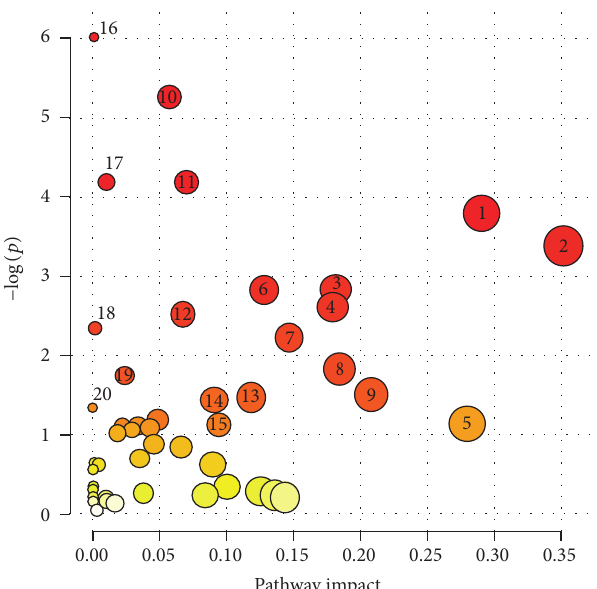
Figure 2: Metabolic pathway analysis. Metabolic pathway analysis was performed with MetaboAnalyst 3.0. Calculated p value was established based on the pathway enrichment analysis while pathway impact value based on the pathway topology analysis. Twenty of the most significant pathways are marked with the numbers: 1. phenylalanine metabolism, 2. taurine and hypotaurine metabolism, 3. arginine and proline metabolism, 4. pantothenate and CoA biosynthesis, 5. pyruvate metabolism, 6. biotin metabolism, 7. glyoxylate and dicarboxylate metabolism, 8. tryptophan metabolism, 9. alanine, aspartate, and glutamate metabolism, 10. aminoacyl-tRNA biosynthesis, 11. valine, leucine, and isoleucine metabolism, 12. beta-alanine metabolism, 13. ascorbate and aldarate metabolism, 14. sphingolipid metabolism, 15. glycolysis and gluconeogenesis, 16. nitrogen metabolism, 17. phenylalanine, tyrosine, and tryptophan biosynthesis, 18. glycine, serine, and threonine metabolism, 19. pyrimidine metabolism, and 20. arginine and ornithine